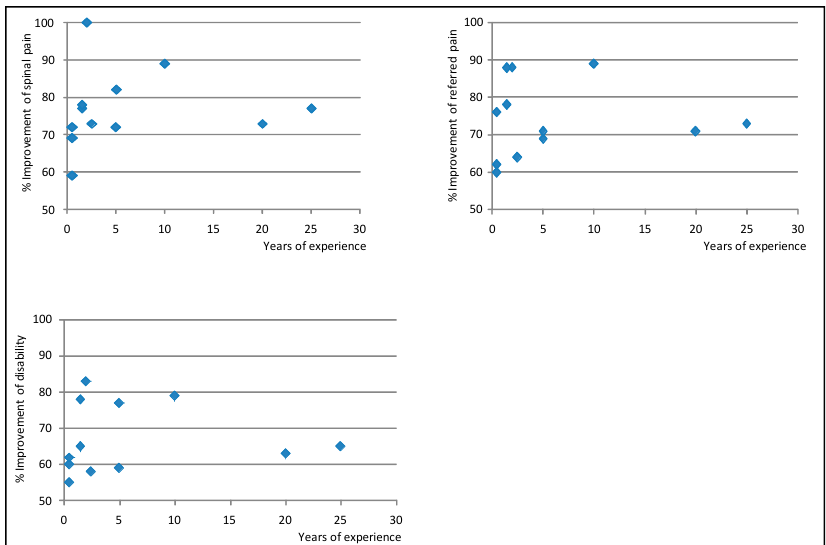
Figure 4. Years of experience for each physician, and improvement in neck and back pain, referred pain, and disability *. *: Note that the figure shows improvement in pain and disability between 50% and 100% of baseline values (not between 0 and 100%). Therefore, differences across physicians appear to be larger than they are.